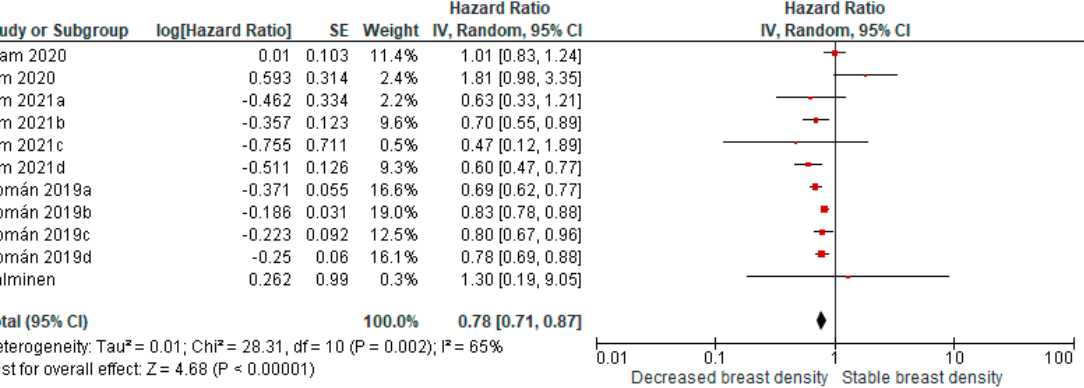
Figure 4. Pooled analysis for breast cancer risk in relation to decreased breast density over time (cohort studies). Kim